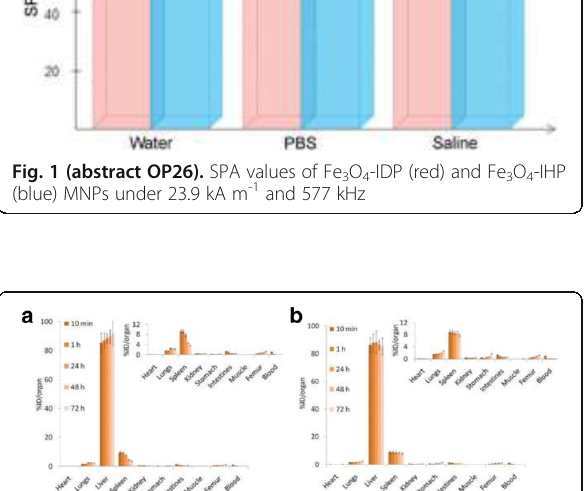
Fig. 1 (abstract OP27). HPLC analyses of the mixture of sugars commonly analyzed in FDG quality